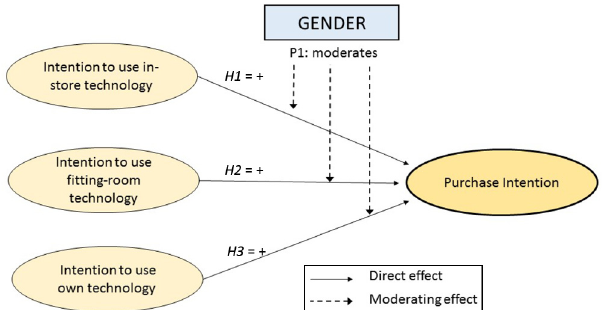
Figure 1. Research